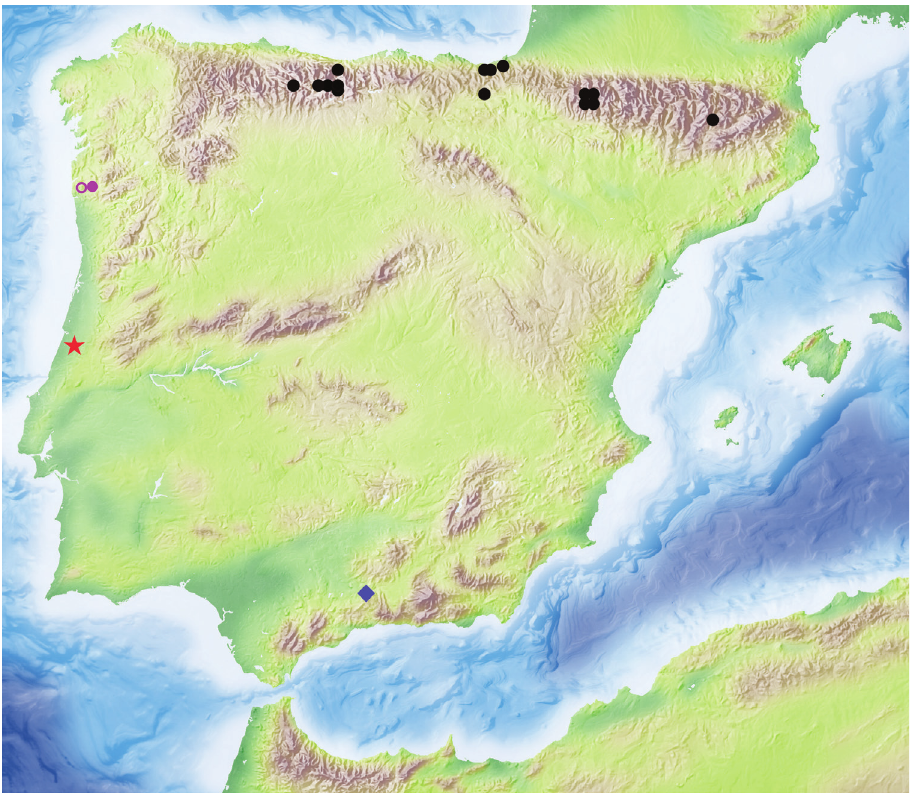
Figure 6. Distribution map of the Iberian species of Rhithrodytes and Iberoporus . Key: red star, I. pluto sp. n.; blue diamond, I. cermenius ; filled purple circle, I. argaensis comb. n.; empty purple circle, I. agnus comb. n.; black circles, R. bimaculatus (data from Millán et al.